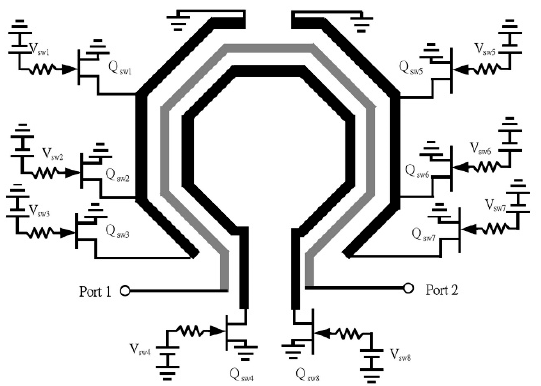
Figure 3. Layout of the multi-tapped switched inductor with two switch-loaded transformers. Table 1. Six modes of sub ‐ bands for the switched inductor.